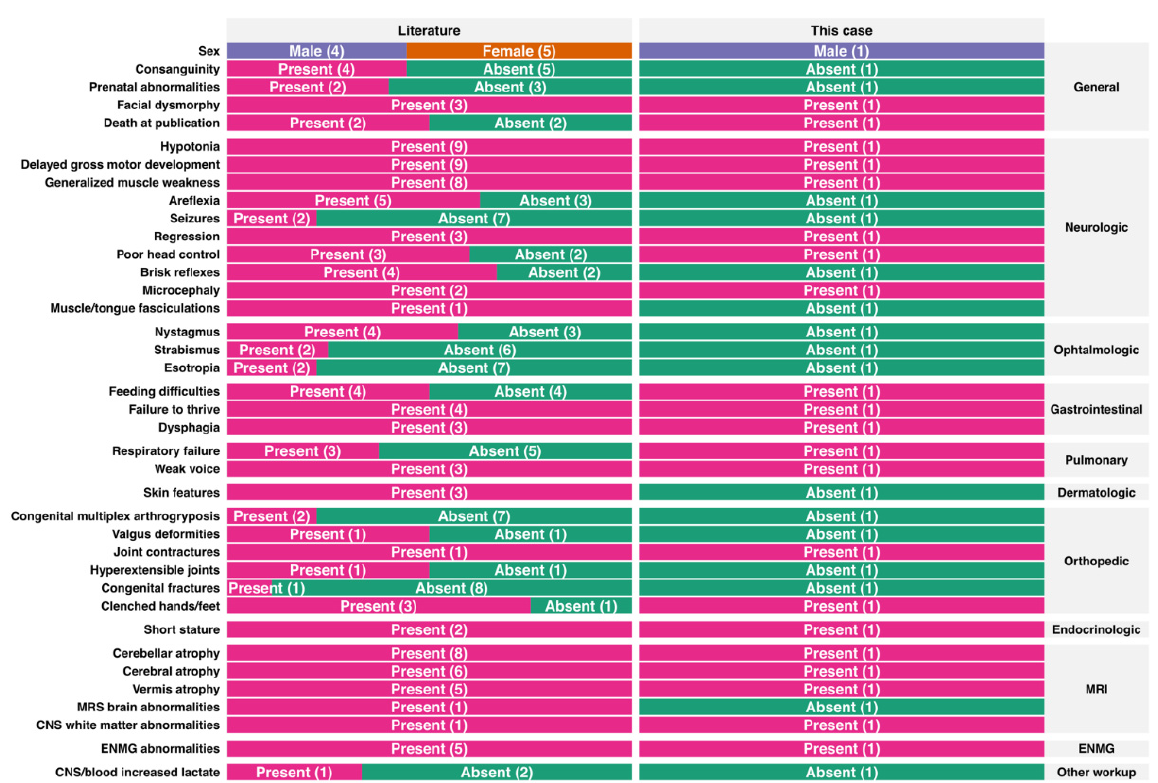
Figure 2. Clinical presentation overview.